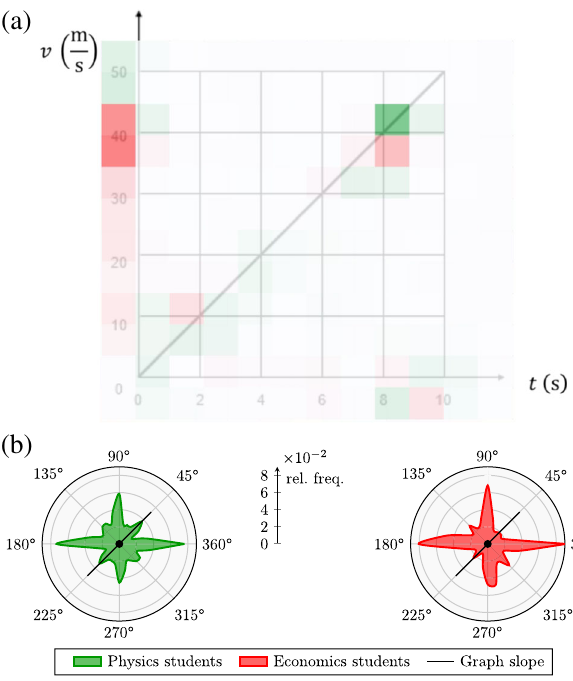
FIG. 10. Analysis of visual attention and saccadic eye move- ments for the qualitative question on area under a graph in the context of physics. Students had to compare the distances covered by two objects after t ¼ 9 h. For more details, please refer to the caption of Fig. 8.